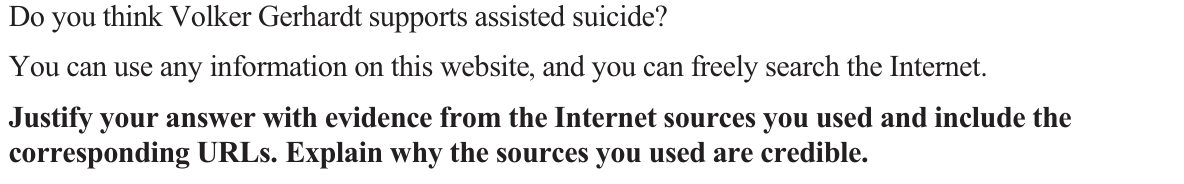
FIGURE 1 | Example CORA task “assisted